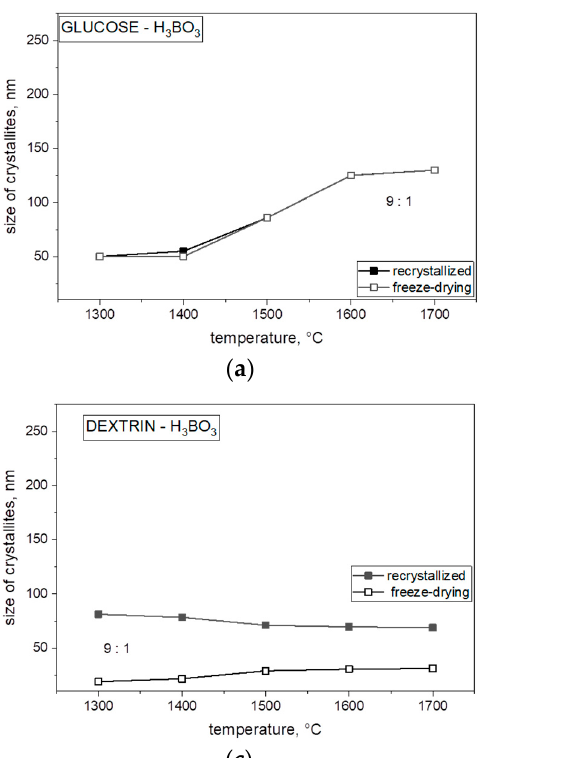
( d ) Figure 8. Temperature dependences of boron carbide content in the prepared powders from recrystallization and freeze-drying: ( a ) glucose, ( b ) fructose, ( c ) dextrin, and ( d ) HES. Analyzing the obtained results in Figure 9, we concluded that the size of crystallites with the use of both freeze-dried and non-freeze-dried saccharides is significantly influ- enced by temperature. The crystallite size for each weight ratio and both freeze-dried and recrystallized precursor increased significantly at 1700 °C and varied with each saccha- ride. By comparing each saccharide with each other, we found that lyophilized polysac- charides had the smallest size of crystallites compared with the same recrystallized pol- ysaccharides. Further particle size increase in boron carbide (B 4 C) may be related to the